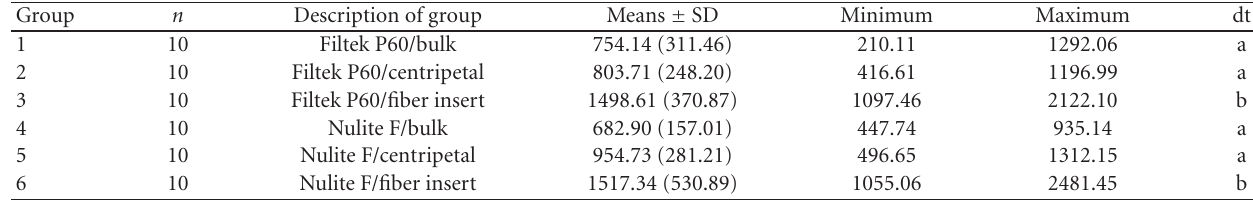
Table 2: Means ± standard deviation, minimum, and maximum in Newton for experimental